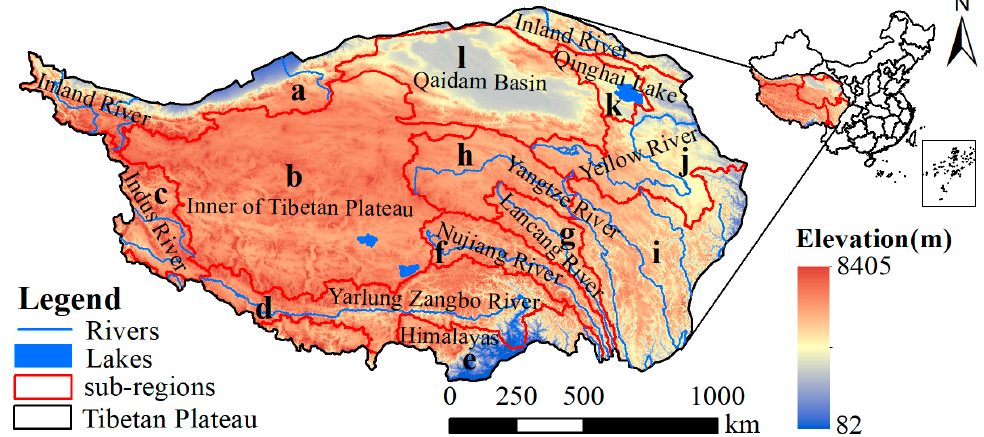
Figure 1. Schematic diagram of the geographic location of the Tibetan Plateau.